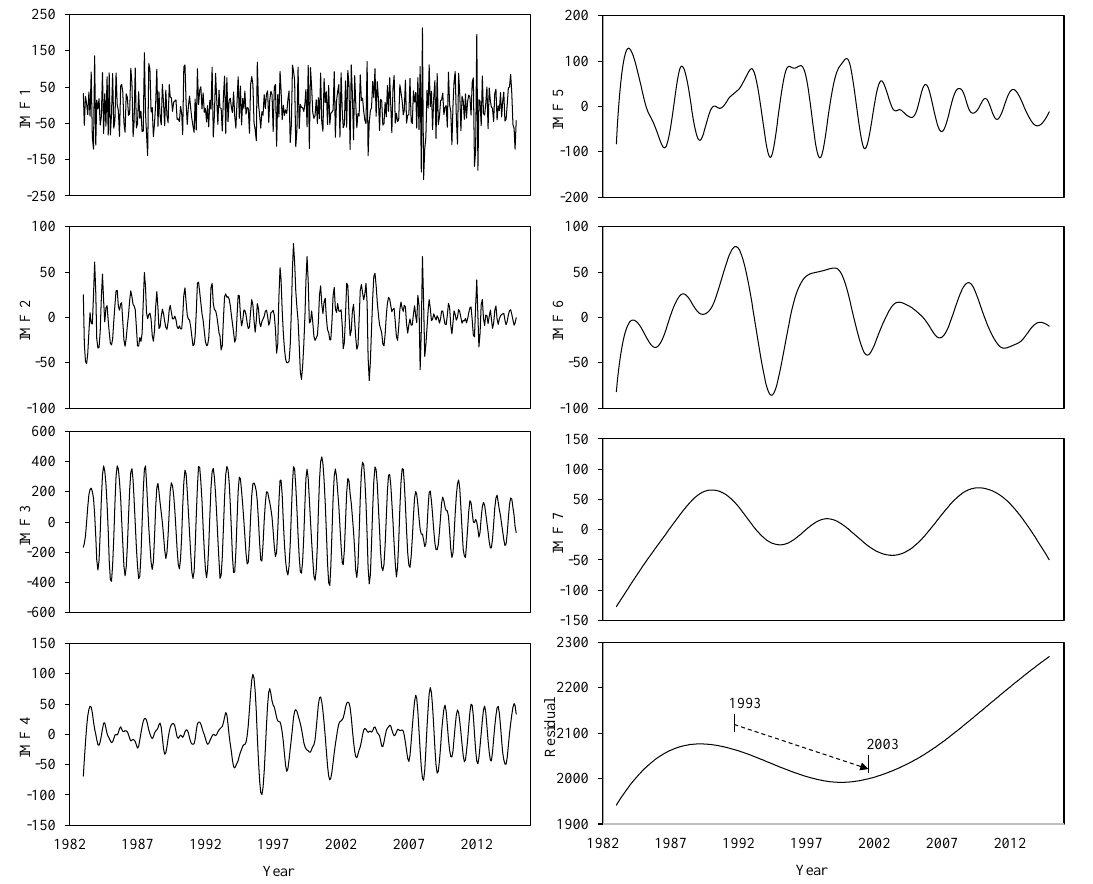
Figure 7. Complete ensemble empirical mode decomposition (CEEMD) consists of intrinsic mode functions (IMFs) and residuals for the sea-level time-series data from Cox’s Bazar tide gauge station for the period of 1983 – 2014.